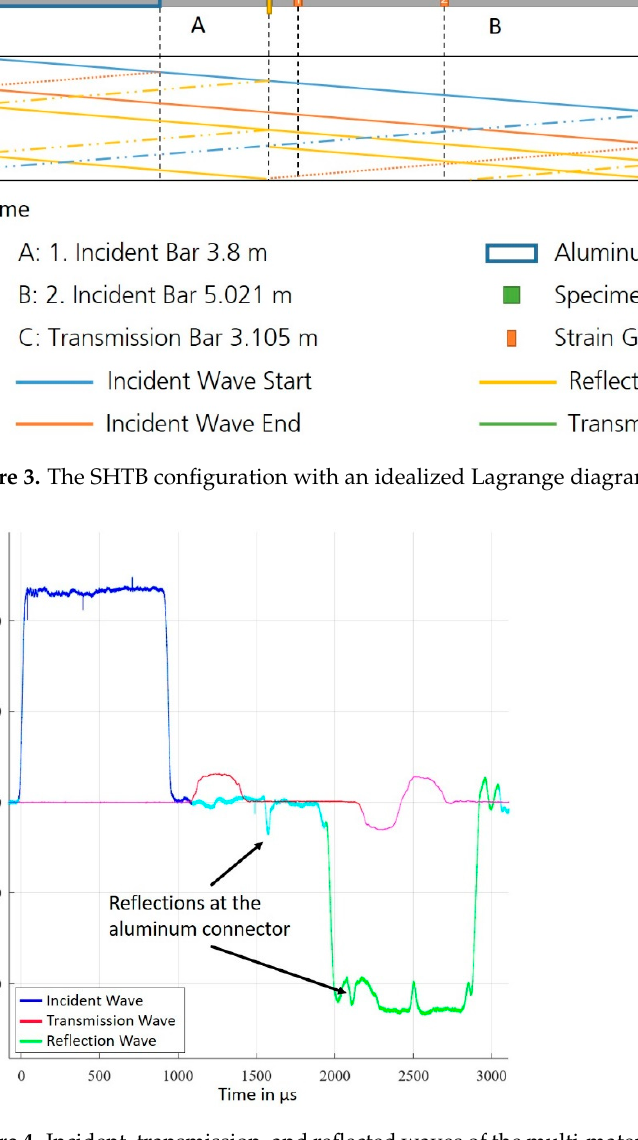
Figure 4. Incident, transmission, and reflected waves of the multi-material bolted experiment BT-